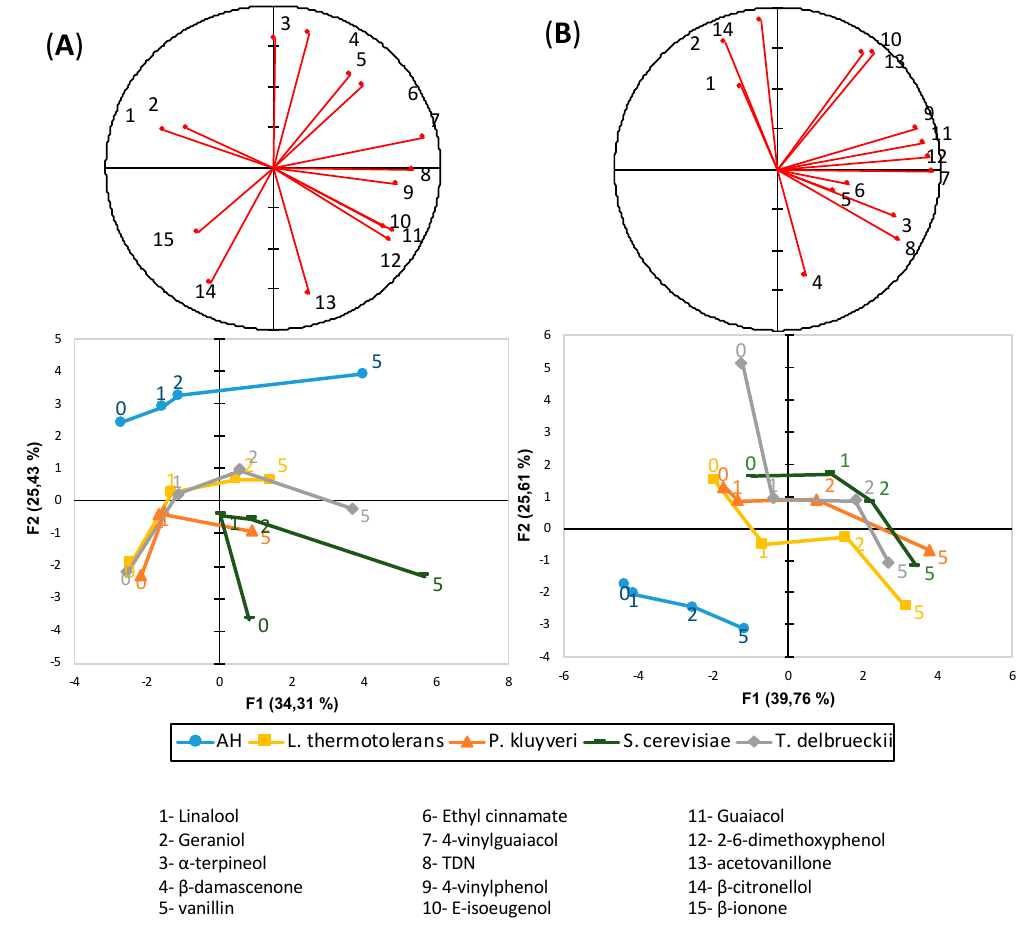
Figure 5. The principal component analysis carried out with the varietal aroma compounds quantified in ( A ) Riesling and ( B ) Garnacha from all of the fermented samples. The plot shows the projection of the variables (top plot) or samples (bottom) average of two biological replicates—in the plane formed by the first two components, which retained 59.74% and 65.37% of the original variance, respectively. The numbers in the samples refer to the weeks of anoxic storage at 50 °C, and each strain pattern is highlighted with a line.